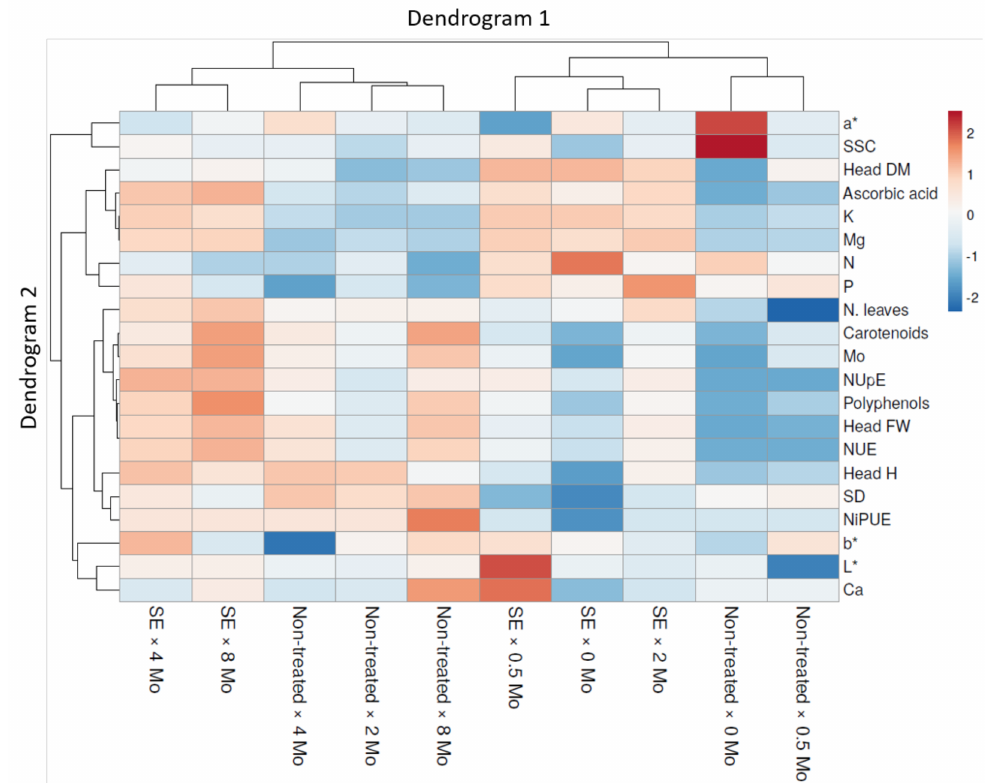
Figure 4. Heat map analysis comprising all spinach plant traits in response to SE application and Mo-biofortification. The heat map picture was made via the https://biit.cs.ut.ee/clustvis/ (accessed on 27 April 2021) online program